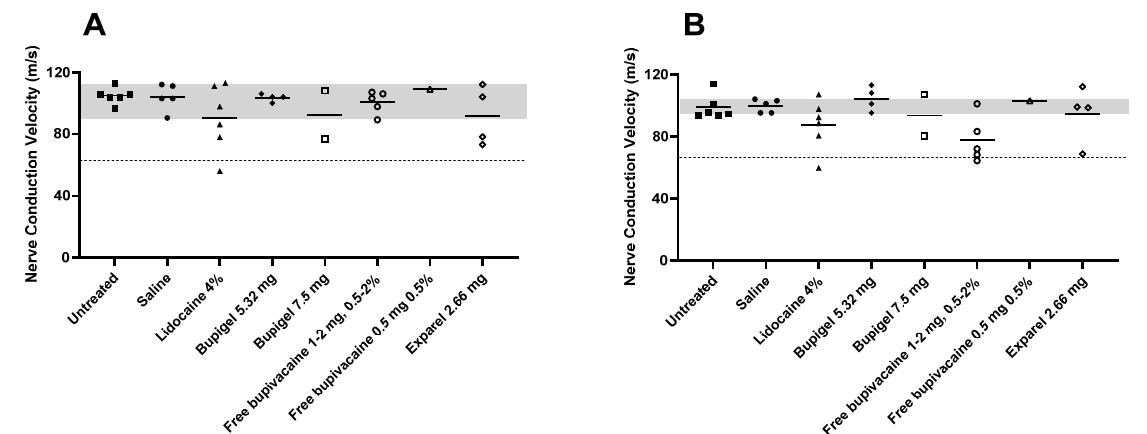
Figure 3. Effect of different formulations on rabbit sciatic nerve conduction velocity (NCV). Individual values for tibial ( A ) and peroneal ( B ) NCV two weeks after perineurial administration of the different formulations. The gray area in the background indicates the range of values for the saline group to facilitate visualization. The dashed line represents the calculated threshold of demyelinative nerve damage (>30% below lower limit of saline value). Saline n = 5, lidocaine 4% n = 6, Bupigel 5.32 mg n = 4, Bupigel 7.5 mg n = 2, free bupivacaine 0.5 mg at 0.5% n = 1, free bupivacaine (1–2 mg at 0.5–2%) n = 5 (1 limb per dose and concentration tested), Exparel ® n = 4, untreated/naïve n = 6, n = number of legs.